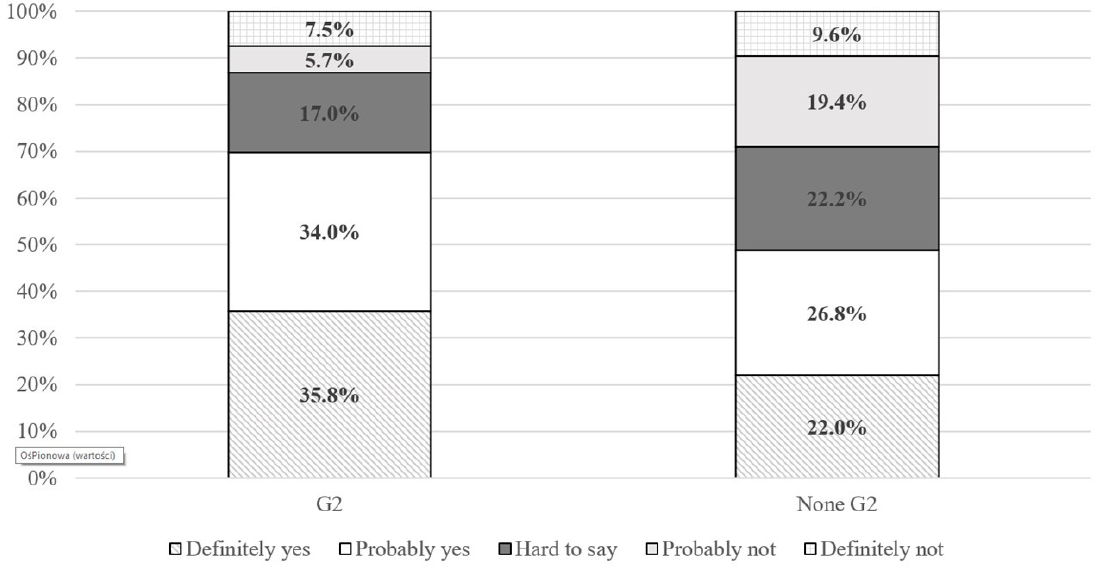
Figure 3. Distributions of responses to the statement “I am afraid of losing my job because of the situation”, contrasting members of G2 with all other respondents (G2, n = 53; Non-G2, n = 948).